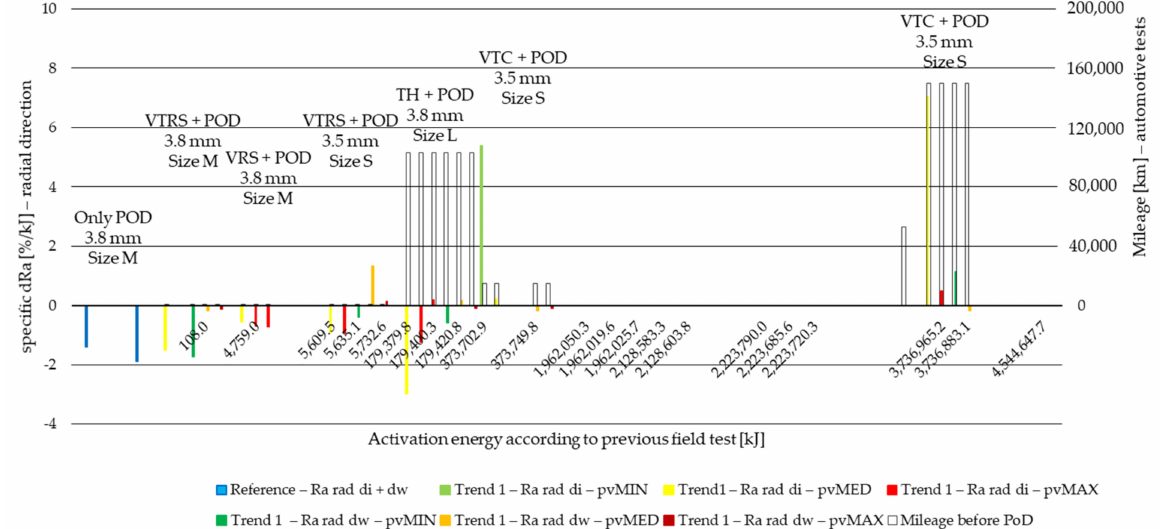
Figure 14. Radial direction PoD specific Ra difference values of cut material samples from inner and working diameter after minimum, medium and maximum pv level pin-on-disc tests with previous